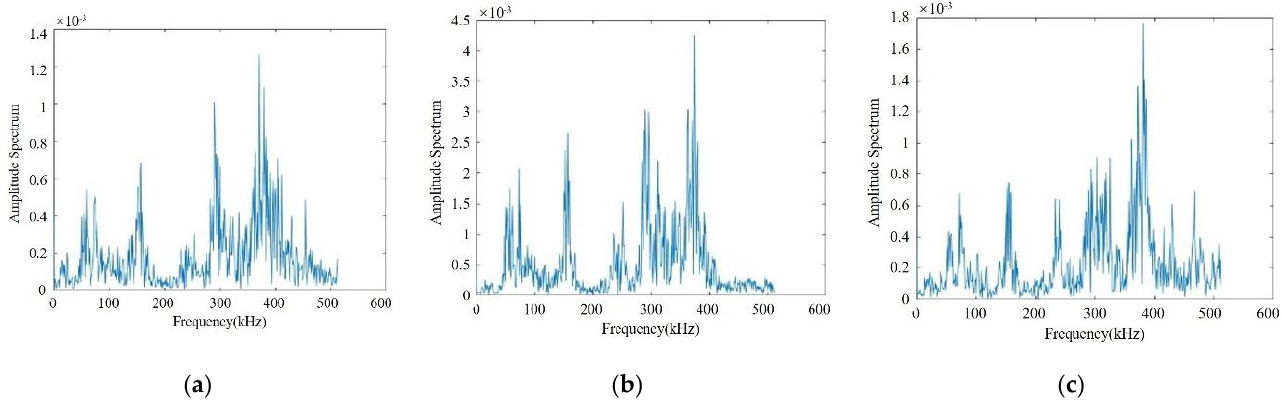
Figure 10. Frequency domain waveform of the P-signals of each sample. ( a ) A1.No.17715, ( b ) B1.No.8200, ( c ) C1.No.6375.